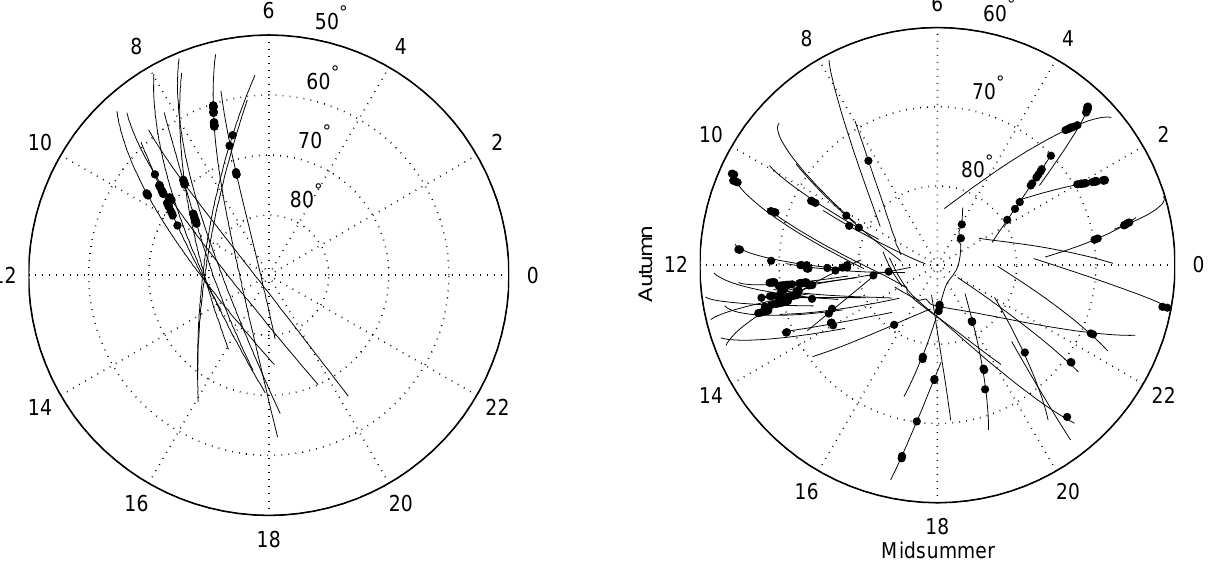
Fig. 3. Diagram with Magnetic Local Time (MLT) and invariant latitude, showing the investigated data intervals (the lines) and the location of the identified LHCs (the dots) in the Viking data set. The total number of LHCs is 166, so many of the dots in the figure overlap. The altitudes of the orbits are shown in Fig. 7.